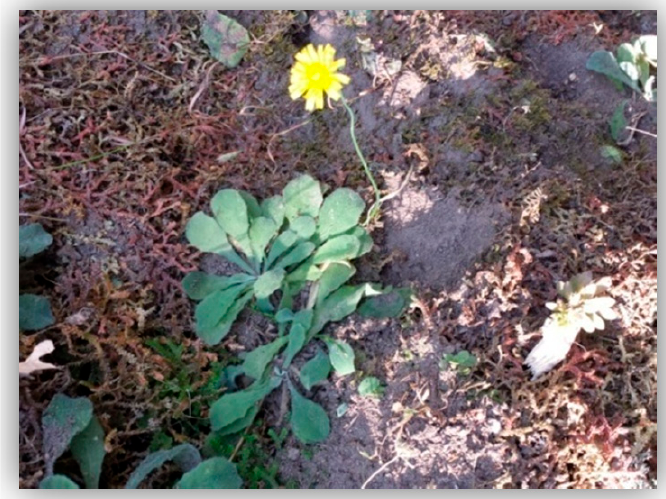
Figure 1. The plant of Hypochaeris laevigata var. hipponensis .